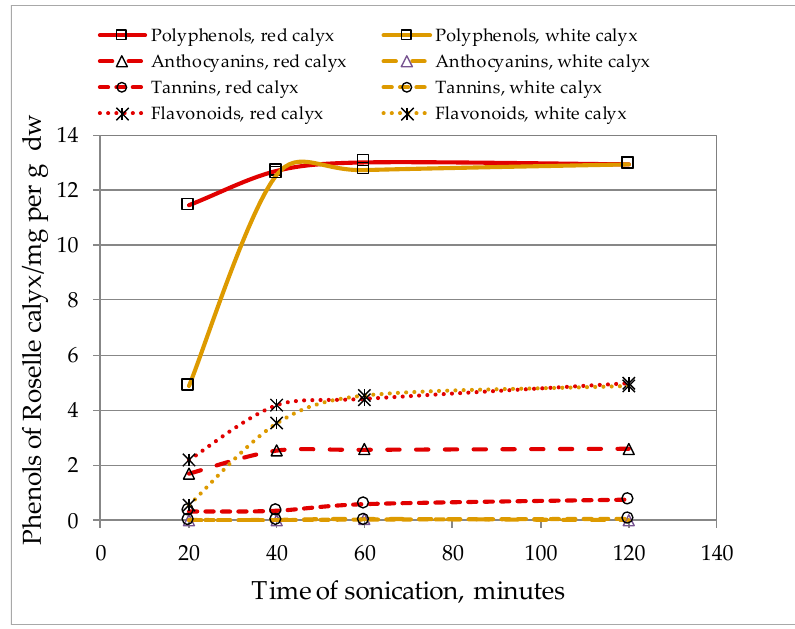
Figure 2. Influence of time of sonication over yield of bioactive compounds in the ultrasound-assisted extraction process.